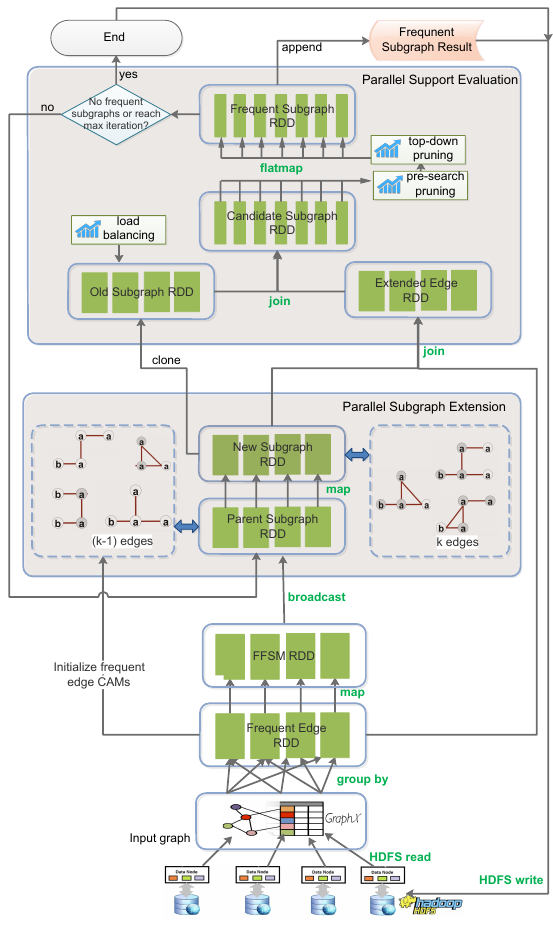
Figure 4. Framework of the SS I G RA M(Spark based Single Graph Mining) approach. Green notations on the right side are main Spark resilient distributed dataset (RDD) transformations or actions used during the algorithm pipeline. Abbreviations: CAM (Canonical Adjacency Matrix), HDFS (Hadoop Distributed File System), FFSM (Fast Frequent Subgraph